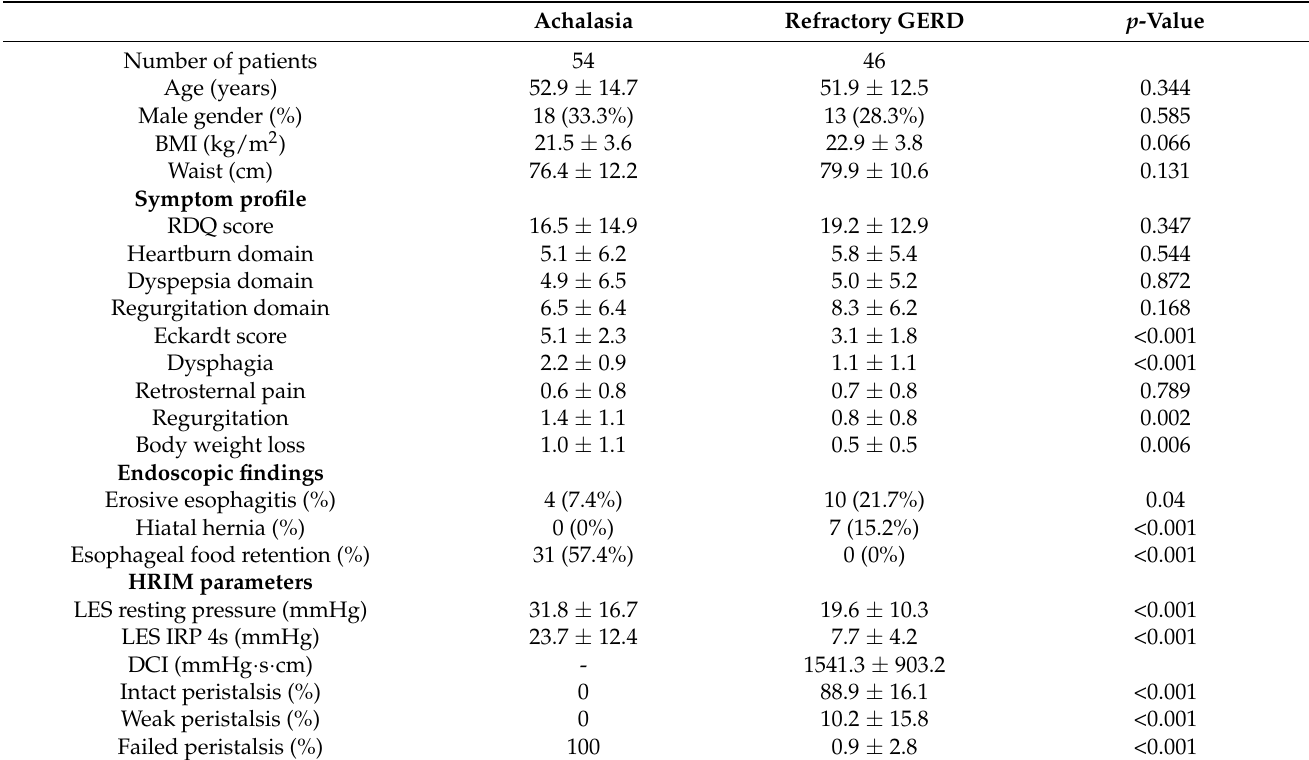
Table 2. Clinical characteristics of patients with achalasia and refractory